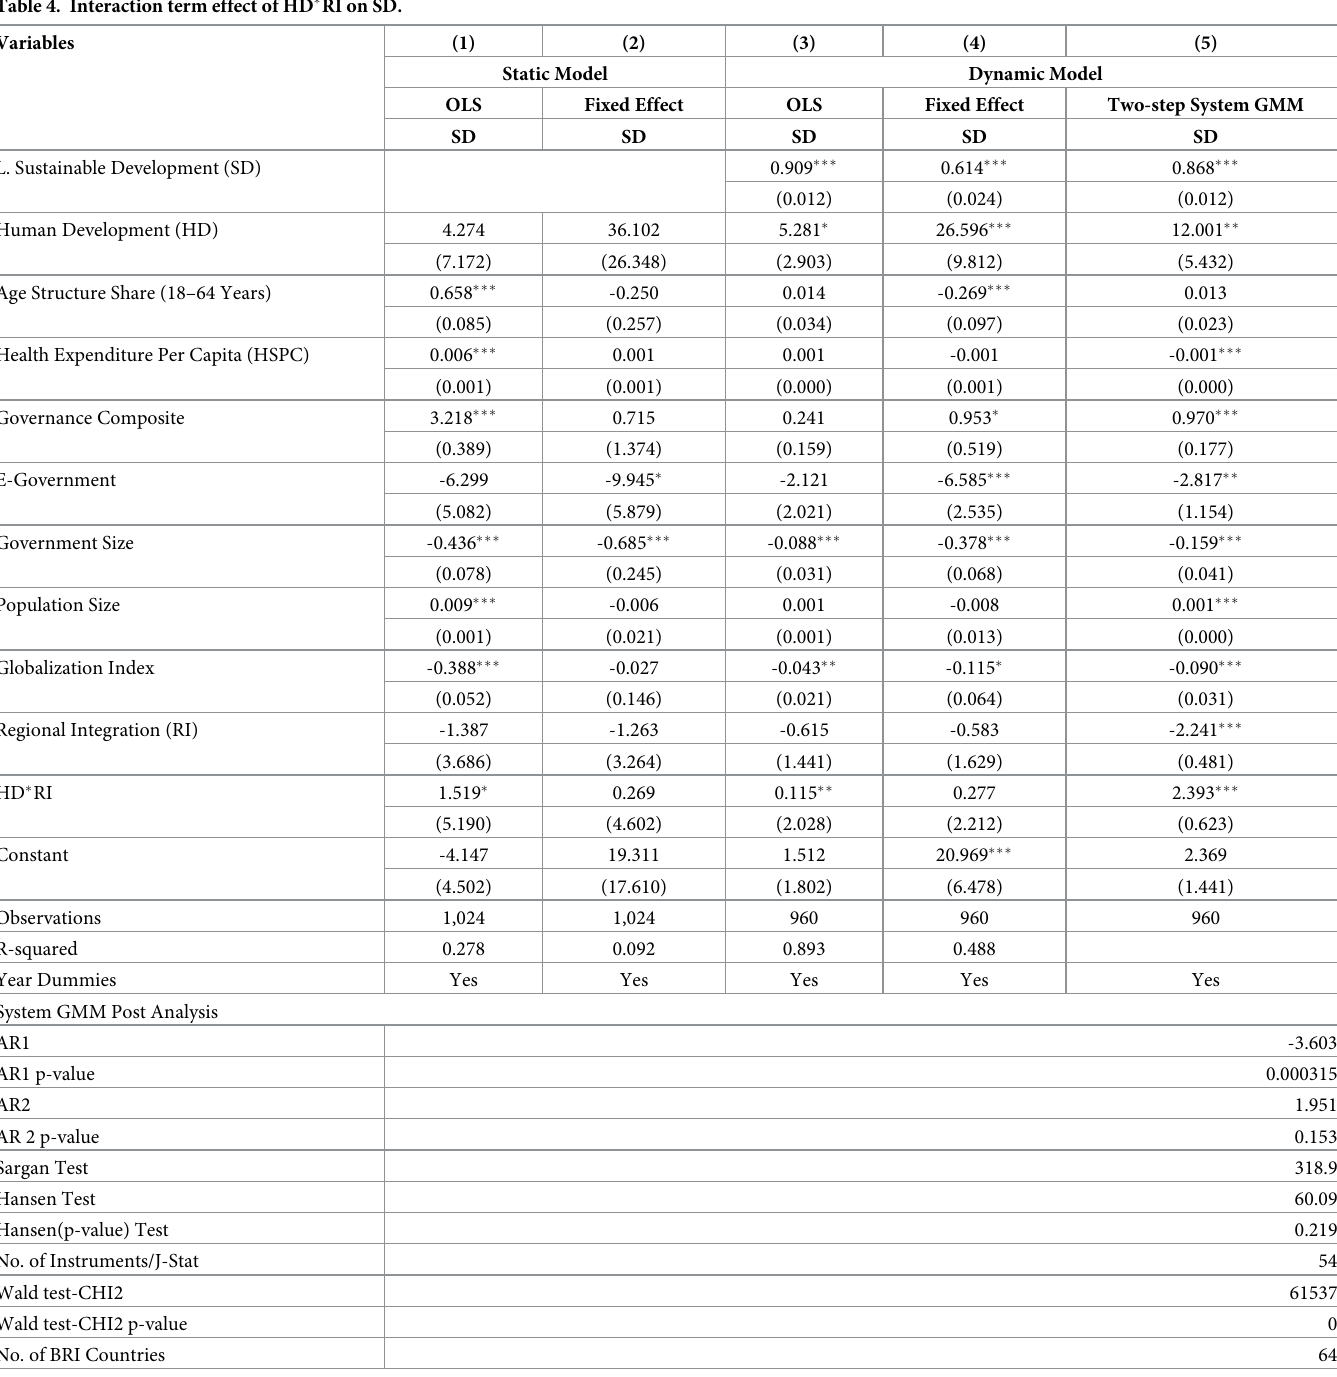
Table 4. Interaction term effect of HD � RI on